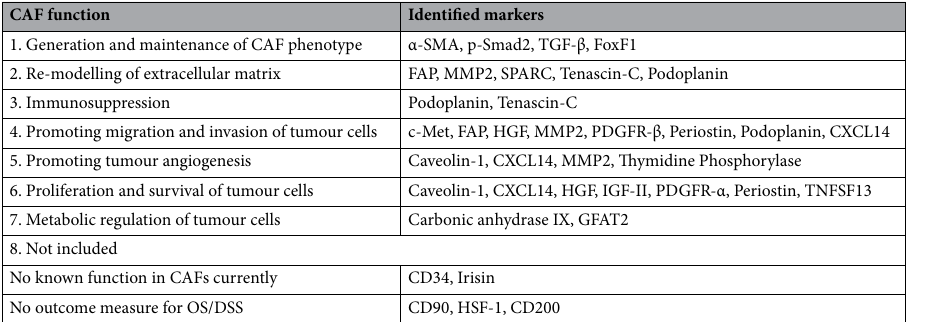
Table 3. Summary of the CAF functions and the role of each identified marker.